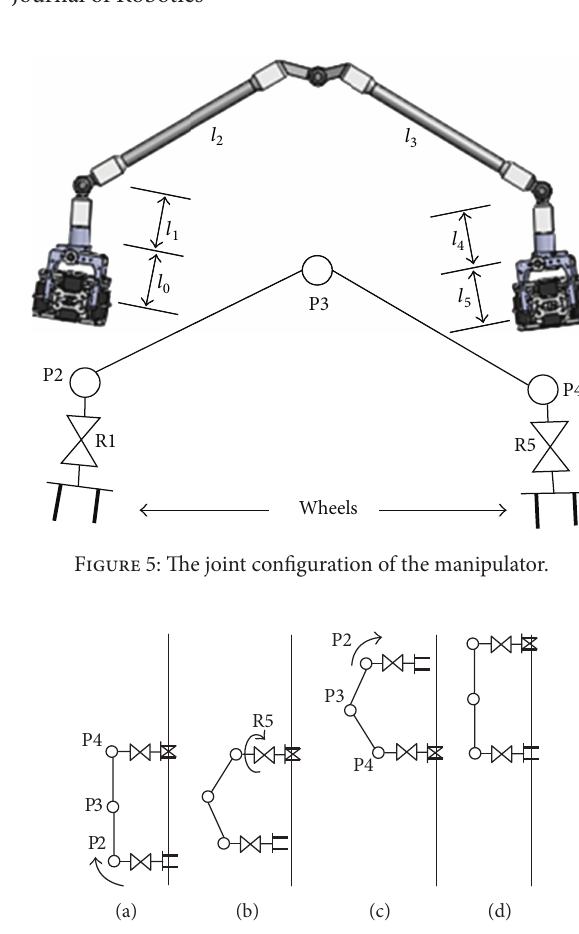
Figure 6: The gait for turn around gait.